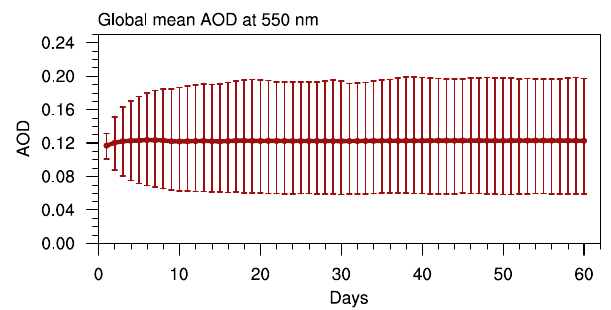
Figure 9. Time evolution of the global mean aerosol optical depth Fig. 9. Time evolution of the global mean aerosol optical depth (AOD, at 550nm wavelength) in the ensemble simulations de- (AOD, at 550 nm wavelength) in the ensemble simulations de- scribed in Sect. 4. The thick curve shows the AOD averaged over scribed in Sect. 4. The thick curve shows the AOD averaged over 256 ensembles that used different values for 16 empirical param- 256 ensembles that used different values for 16 empirical param- eters in the CAM5 model (cf. Table 2). Vertical bars indicate the eters in the CAM5 model (cf. Table 2). Vertical bars indicate the spread (minimum to maximum) among the 256 ensembles. spread (minimum to maximum) among the 256 ensembles.